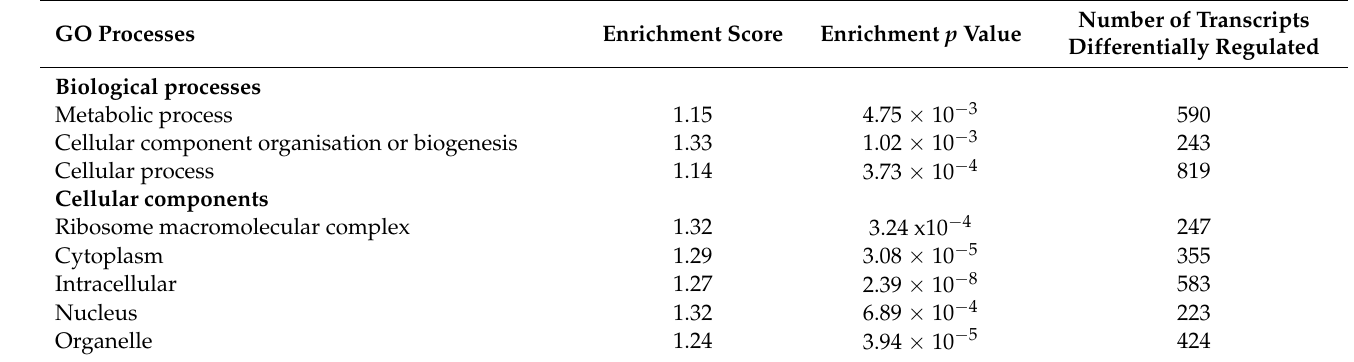
Table 4. GO enrichment analysis of transcripts regulated by low magnesium concentration. The analysis applied FDR p < 0.005 for enrichment p